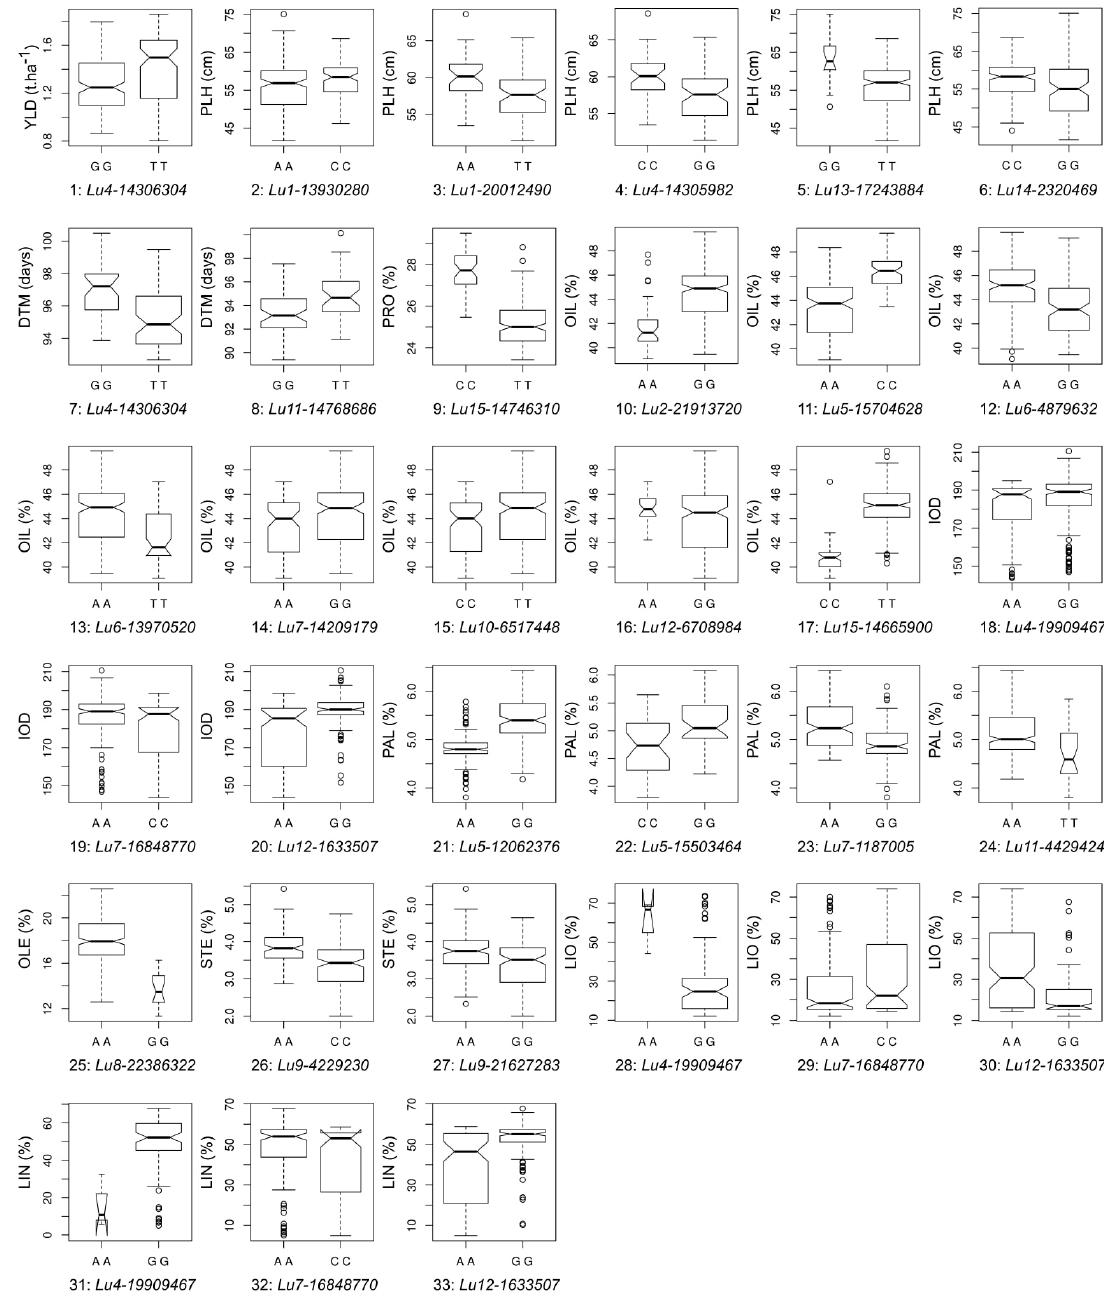
Figure 4. Trait performance of two contrasting haplotype pairs for each of 33 QTL identified from 11 traits. A QTL is represented by the peak SNP identified in the association study. The numbers of QTL correspond to QTL No in Table 3. The BLUP values of the 11 traits in the merged population were used except for PLH/QTL 3 and DTM/QTL 7 for which BM population was used, DTM/QTL 8 for which EV population was used, and PAL/QTL 22, LIO/QTL 28 and LIN/QTL 31 for which SU population was used. The box width is proportional to the size of the subpopulations. Phenotype differences between two contrasting haplotype pairs for each QTL are shown by boxes’ notches. For any given QTL, boxes’ notches that do not overlap indicate significant median differences at 95% confidence level.